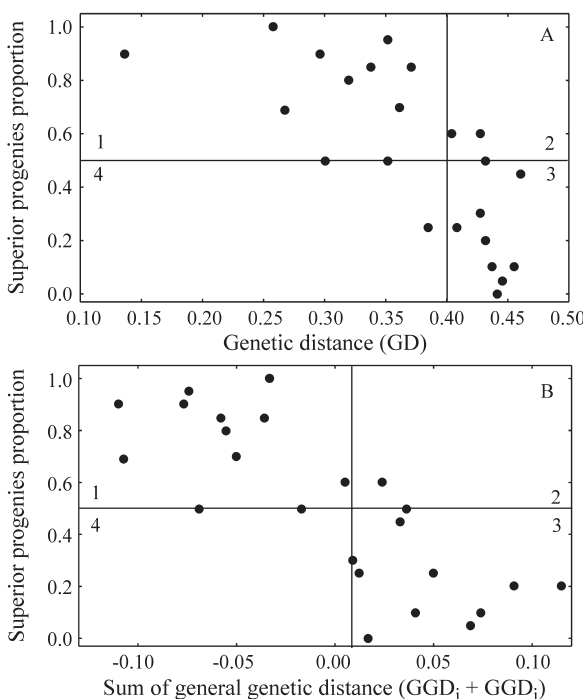
Figure 3 - Relationship between the proportion of superior progenies for seed yield as estimated in the combined analysis with (A) genetic dis-